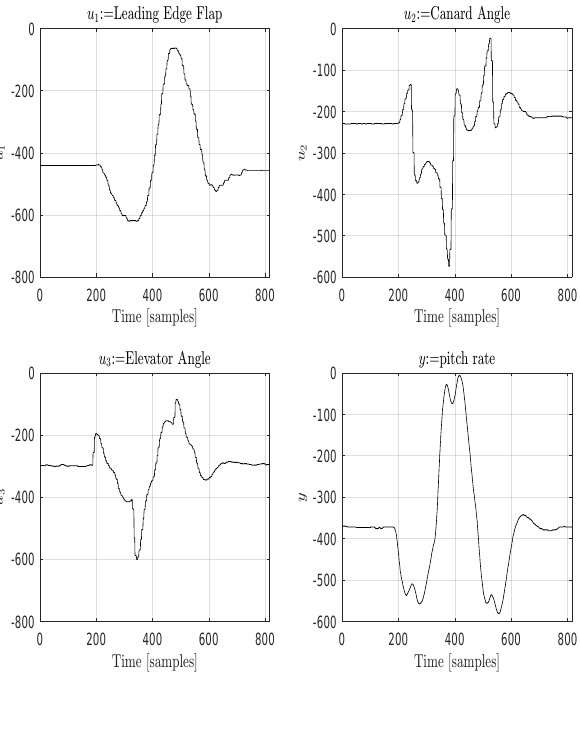
Figure 4: Example 4.3. JAS Gripen test flight raw data. 817 samples correspond to Gripen test flight over 3 s with a sample interval of 1/60 s. These data are the result of reverse engi- neering of figure 2 in Ljung (2013).